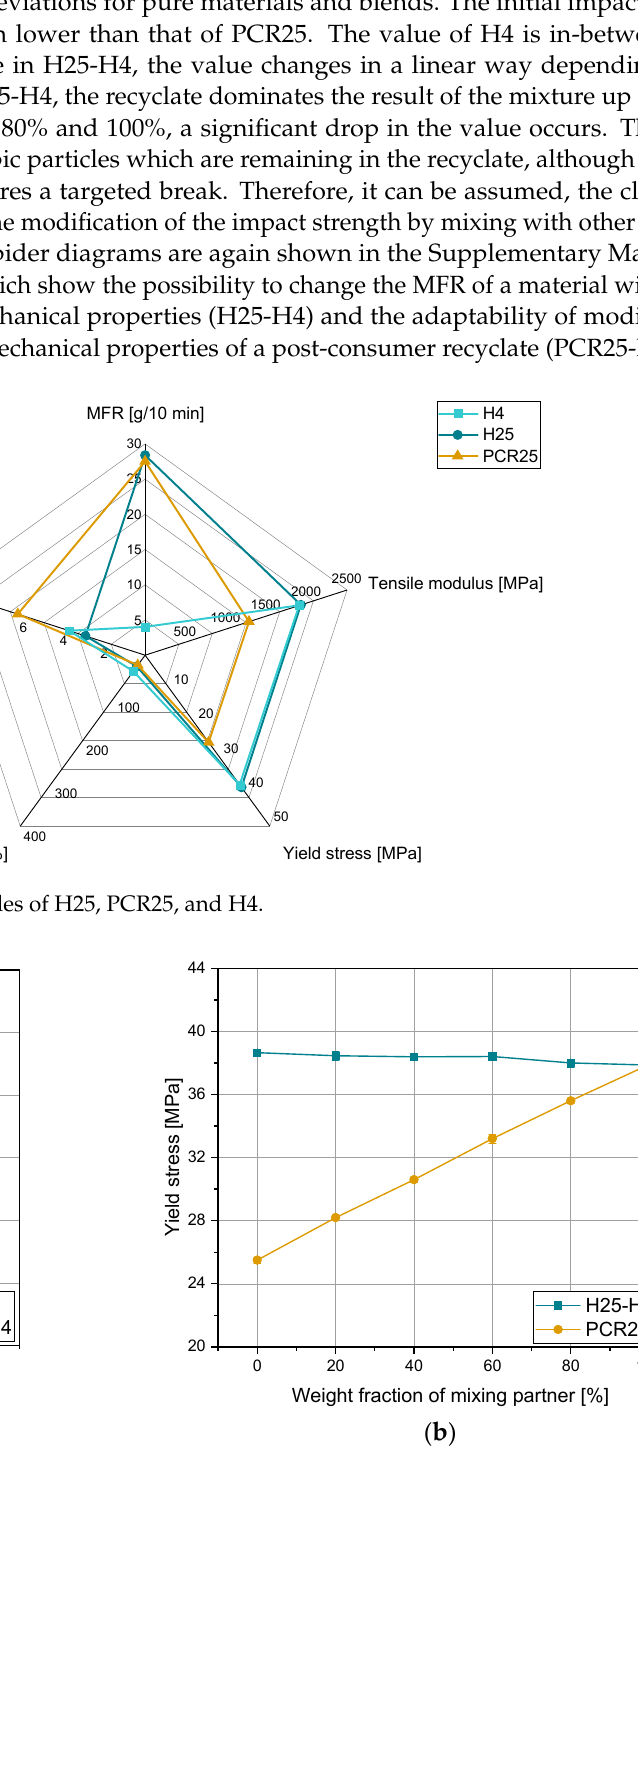
( d ) Figure 6 . Mechanical properties ( a ) tensile modulus, ( b ) yield stress, ( c ) strain at break, and ( d ) Charpy NIS of blends with H25 and PCR25. 4. Discussion The fl owability of a material can easily be adjusted by blending with a material part- ner with a di ff erent MFR. While it was already tested to change the MFR of a broad range of materials with a homopolymer with an MFR of 4 g/10 min as a blending partner [31], for this work, the MFR range of the blending partner was extended to both directions. On the one hand, pipe materials (PP-H and PP-B) with a minimum MFR of 0.25 g/10 min, and on the other hand, extrusion materials (PP-H, PP-R, and PP-B) with a constant MFR of 8 g/10 min were tested. For the blends with pipe materials, it was shown that the MFR changed signi fi cantly by adding only small amounts of the blending partner. The MFR changes can be calculated by the mixing rule of Arrhenius. The di ff erent extrusion mate- rials did not show such a clear trend as homopolymers and random copolymers have shown a logarithmic decrease in the MFR following the Arrhenius and Cragoe mixing rules, while blending with block copolymers showed a pronounced linear decrease in MFR. The higher values of the PP-B compared to PP-H and PP-R could be caused by the demolding additives in the used grade. Furthermore, blends with a low MFR di ff erence (e.g., H12-H8, H12-R8, and H12-B8) can also be well approximated with the linear mixing rule.